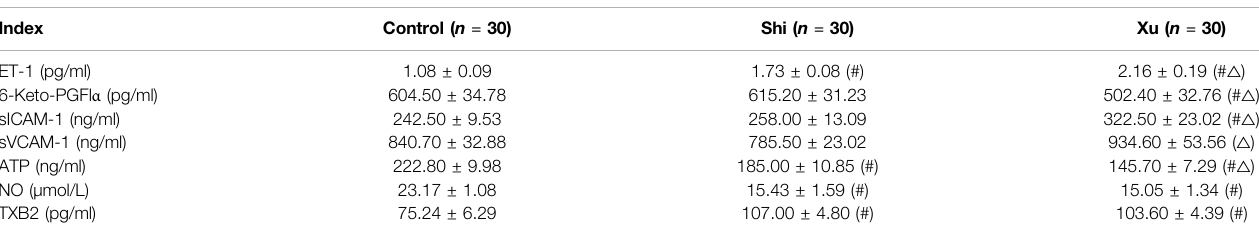
TABLE 3 | Biochemical indexes of participants in the control, Shi-subtype and Xu-subtype groups.